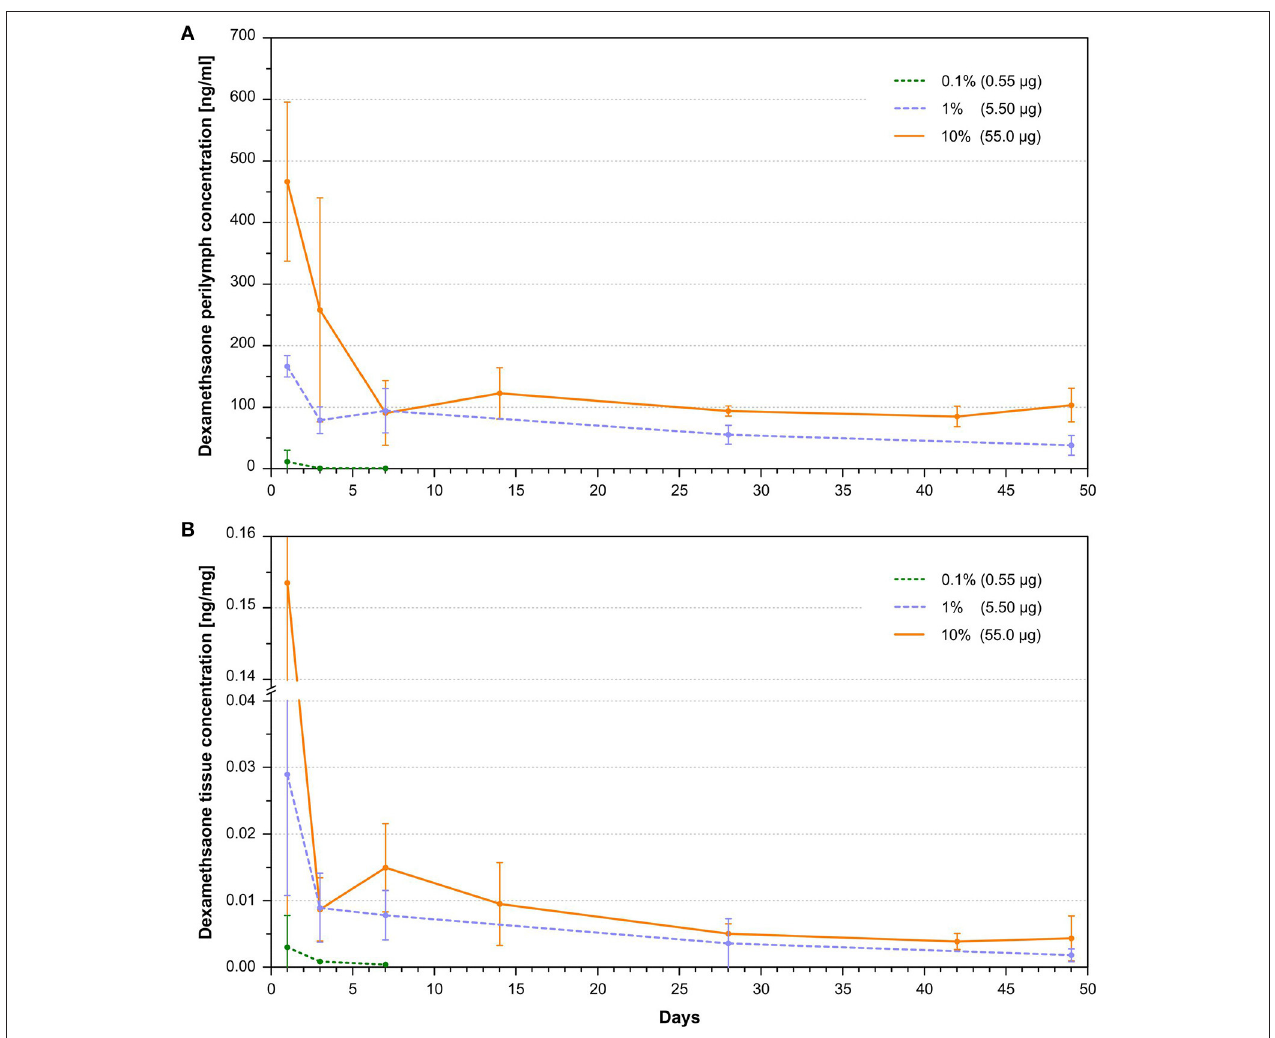
FIGURE 4 | (A) Dependence of perilymph dexamethasone concentration in the scala tympani of implanted animals with 0.1, 1, and 10% loaded dexamethasone silicone rods on time after implantation (mean and SD, n = 3 per sample point). A burst release phase lasting 1–7 days, depending on silicone drug loading, was followed by a steady state phase characterized by constant drug concentrations. (B) Dependence of cochlear tissue dexamethasone concentration of implanted animals with 0.1, 1, and 10% loaded dexamethasone silicone rods on time after implantation (mean and SD, n = 3 per sample point). The concentration time course in tissue drug concentrations reflected the temporal dynamic seen in the perilymph dexamethasone concentrations. Measured concentrations in tissue were 2,000 times lower than perilymph drug